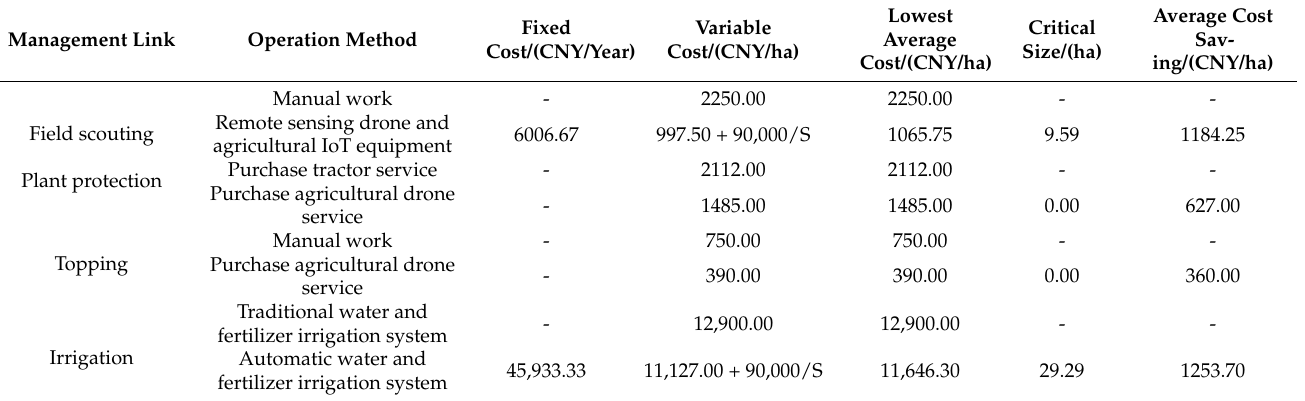
Table 3. The results of the evaluation of the economics of the Super Cotton Field X management link and the traditional management link operation.